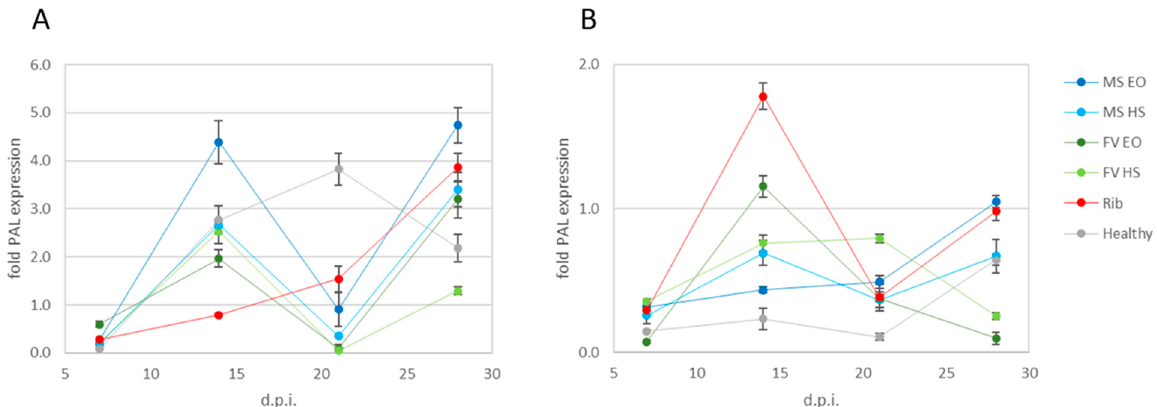
Figure 2. Relative expression of PAL in plants treated at the same time as inoculation ( A ) and treated after inoculation of ZYMV ( B ) in leaves harvested 7, 14, 21 and 28 d.p.i. MS EO = M. suaveolens essential oil; MS HS = M. suaveolens hydrosol; FV EO = F. vulgare essential oil; FV HS = F. vulgare hydrosol; Rib = ribavirin; Healthy = mock-inoculated plants. Values are expressed as means of 2 technical replicates on 3 pooled biological replicates, and bars indicate standard error ( ±